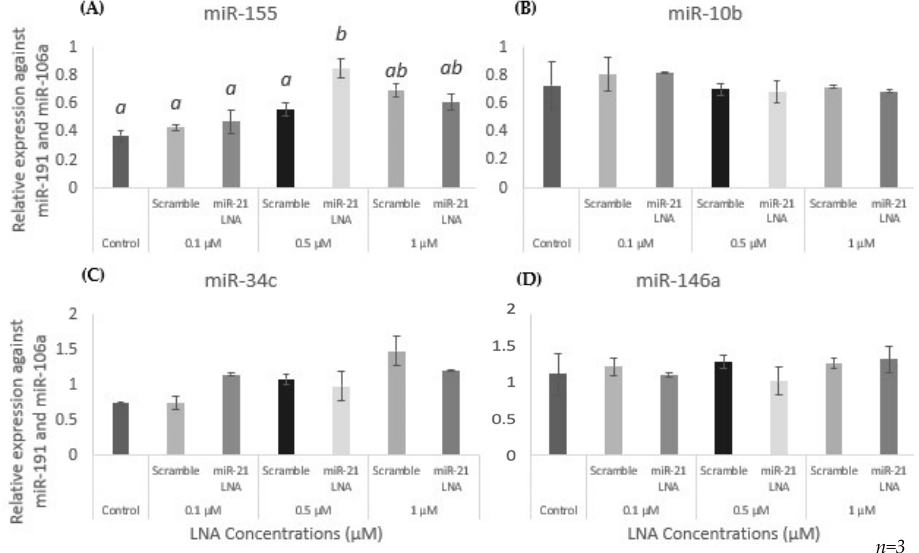
Figure 7. Expression of other miRNAs at different LNA concentrations . miR-155 ( A ) was the only miRNA with induced expression after miR-21 LNA treatment at 0.5 µ M. All other miRNAs: miR-10b ( B ), miR-34c ( C ), and miR-146a ( D ) were unaffected. Transfections with LNA probes at 0.1 μ M, 0.5 μ M, and 1 μ M for 12 h. Quantification is relative to reference targets miR-191 and miR-106a. Different letters indicate significant differences, with b indicating a significantly different mean than a at p < 0.001. ab indicates no differences between a or b . Bars represent the mean ± SEM.